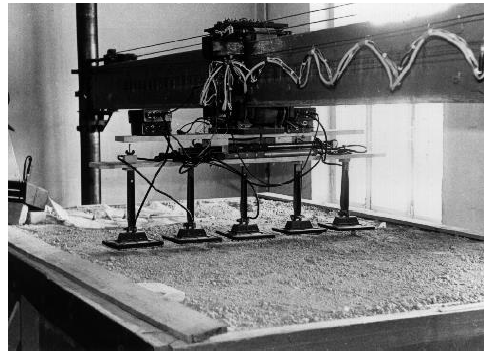
Figure 12. Mock-up of a wide-span system for mine detection.